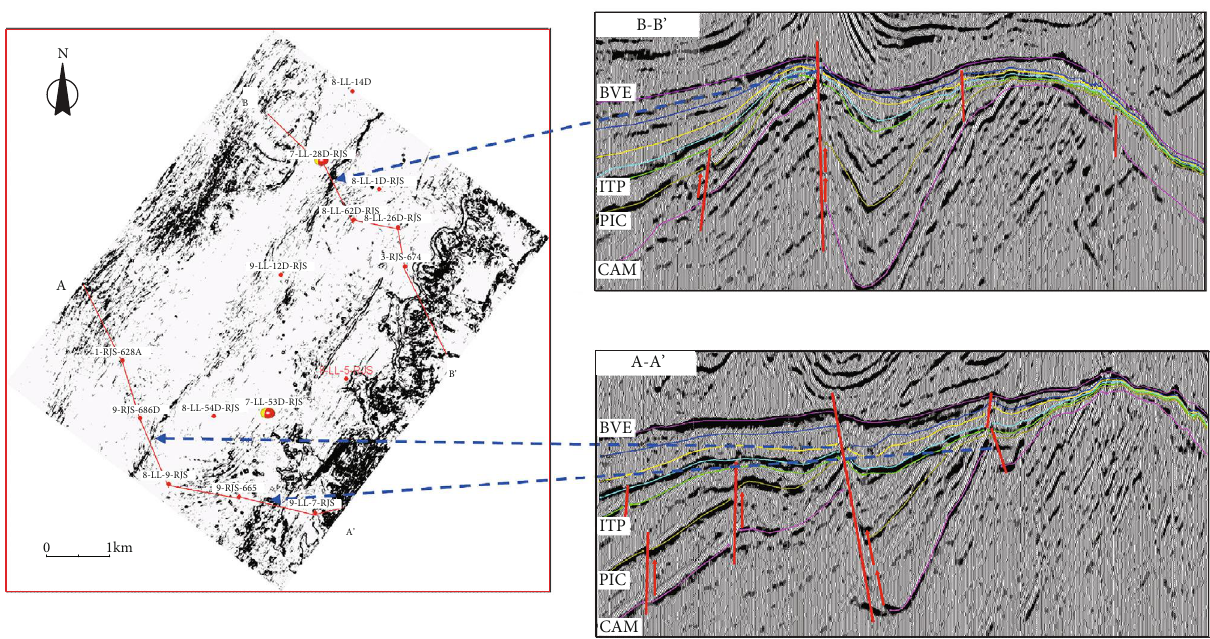
Figure 19: Comparison of the plane and section of the seismic fracture detection